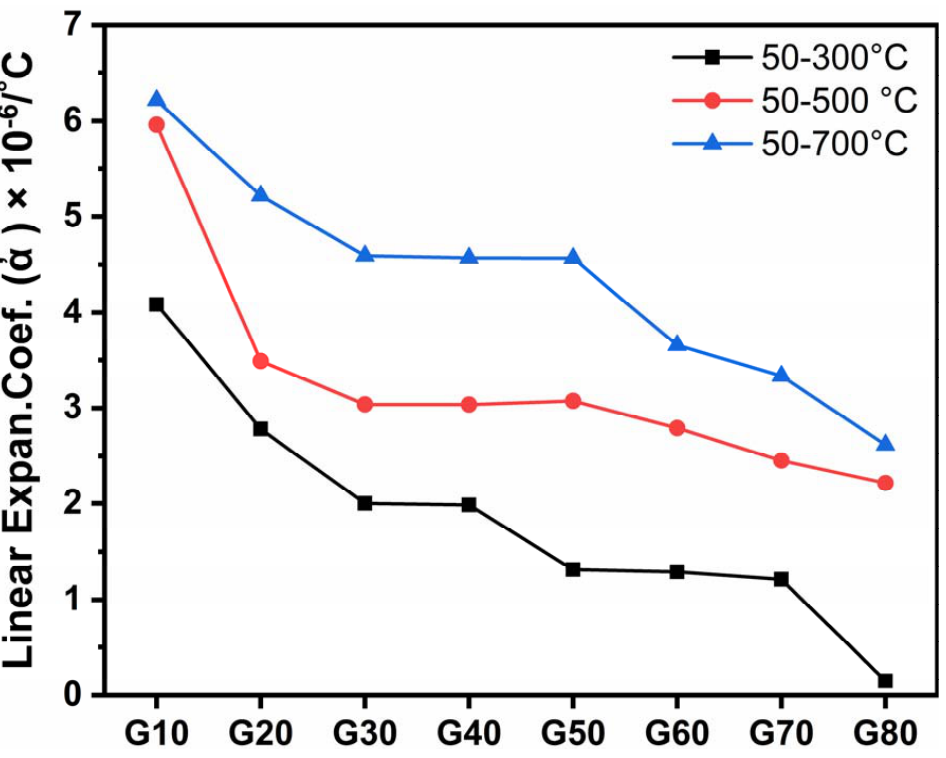
Figure 7. Thermal expansion coefficient of the studied glass–ceramics after heat-treatment at 1000 ◦ C for 2 h. Table 3. Thermal expansion coefficient and phases developed of the investigated samples.